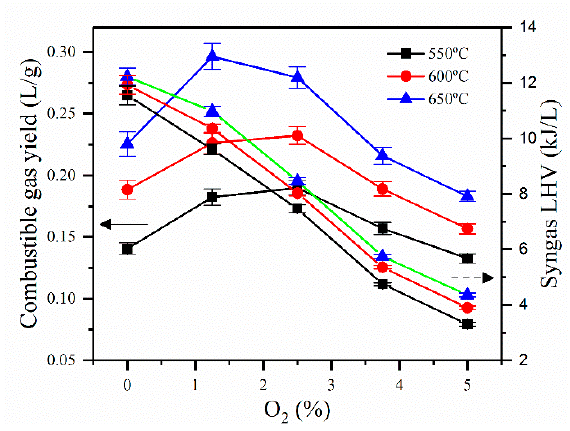
Figure 5. Effects of temperature and oxygen concentration on syngas LHV and combustible gas yield. Figure 5. E ff ects of temperature and oxygen concentration on syngas LHV and combustible gas